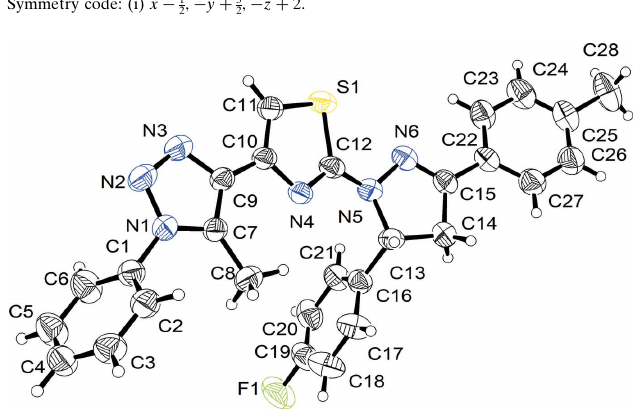
Figure 1 The molecular structure of the title compound showing 50% displace- ment ellipsoids.